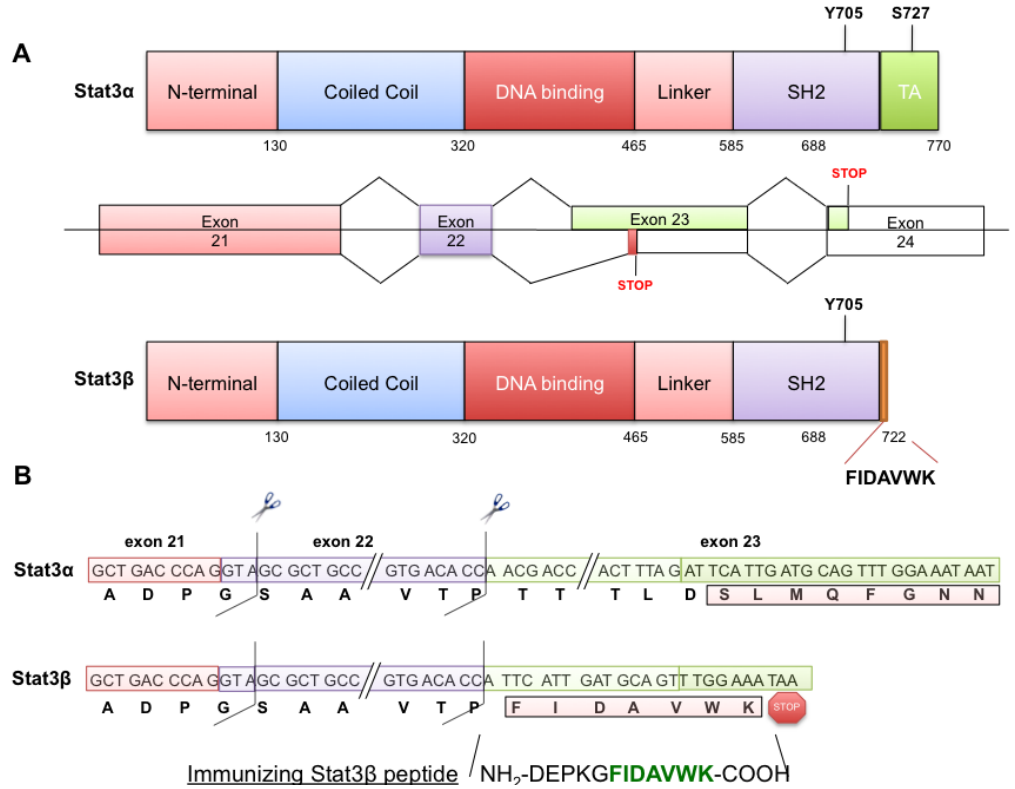
Figure 1. Schematic overview of domains of Stat3α and Stat3β and their derivation by normal splicing of the Stat3 gene or alternative splicing, respectively. Use of an alternative 3' splice acceptor site in exon 23 of the Stat3 gene ( A , middle panel) generates the Stat3β isoform ( A , lower panel) with the loss of 50 nucleotides from the exon and a frame shift, to add 21 nucleotides coding seven unique amino acids followed by a stop codon, within the exon 23 ( A , B lower panels). This leads to a truncated Stat3β in place of the normally intron-spliced Stat3α ( A , B upper